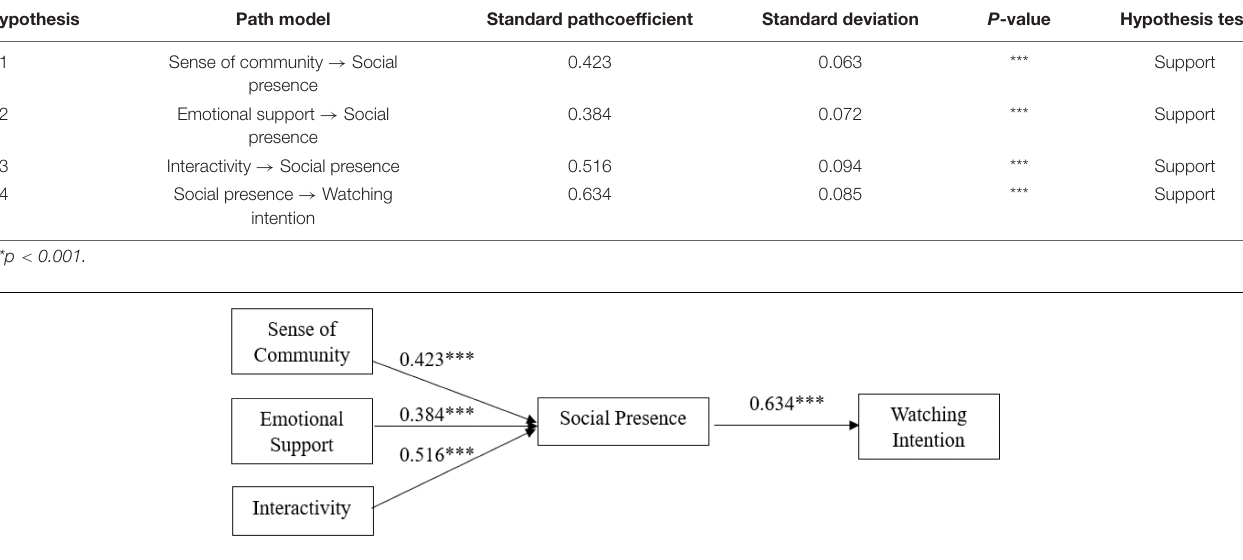
TABLE 5 | Hypothesis test results.